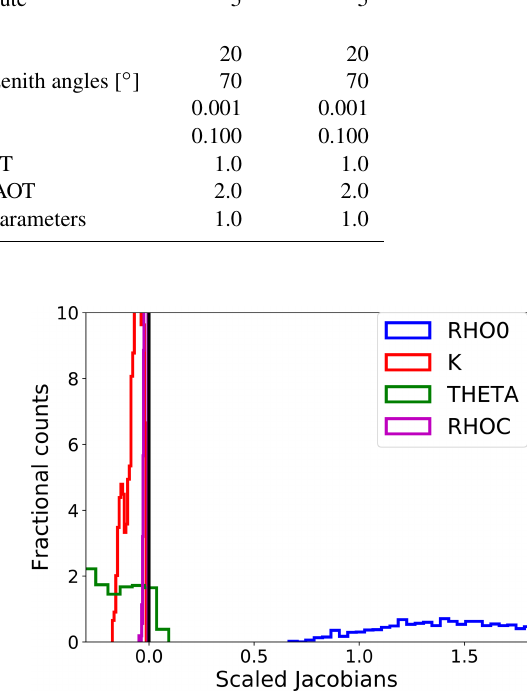
Figure 5. Histograms of the distribution of the Jacobians related to the RPV parameters ( x axis), scaled by the variability range of each variable. These distributions are obtained from PROBA-V ob- servations (RED band) over Carpentras, France (vegetated target). Positive (negative) values of the Jacobian show that the TOA BRF is positively (negatively) correlated to the considered state